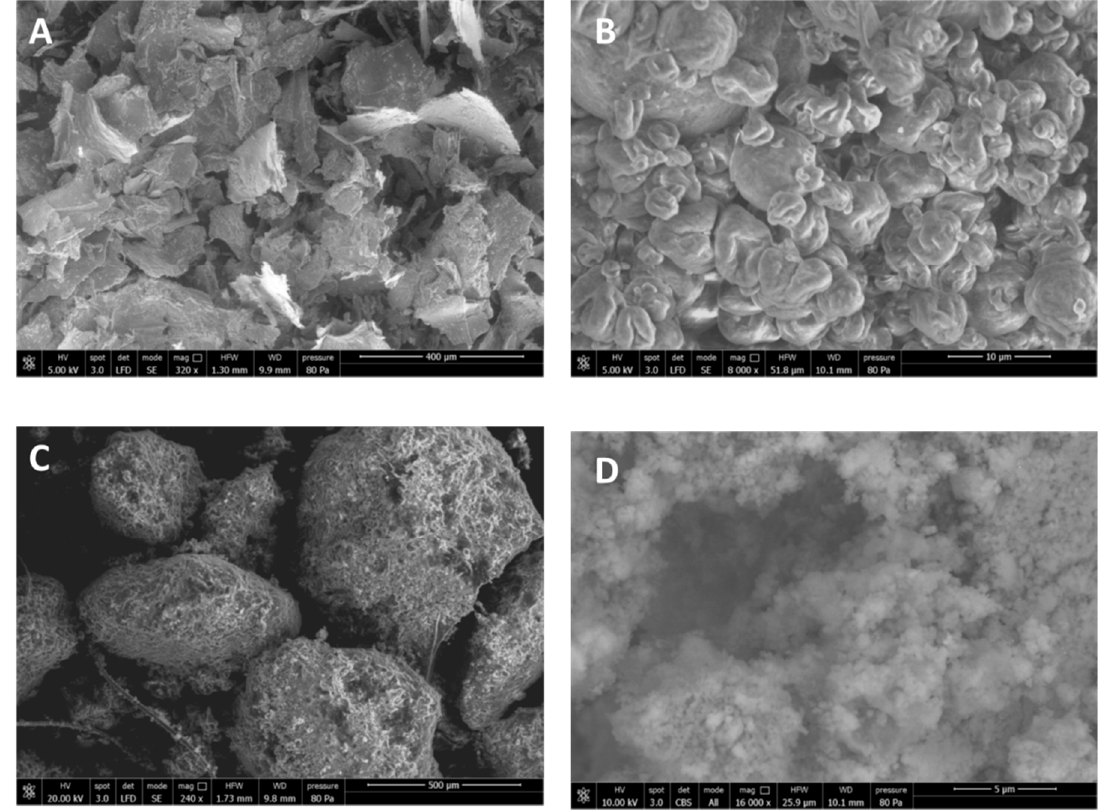
Figure 1. FE-SEM micrographs of the powders: ( A ) Spray dried CN; ( B ) Spray dried CN-NL complex; ( C ) Morphology of NL powder taken from the pristine NL sample; ( D ) Zoomed-in magnification of NL (16,000×) in back scattered modality to observe the NL nanostructure.